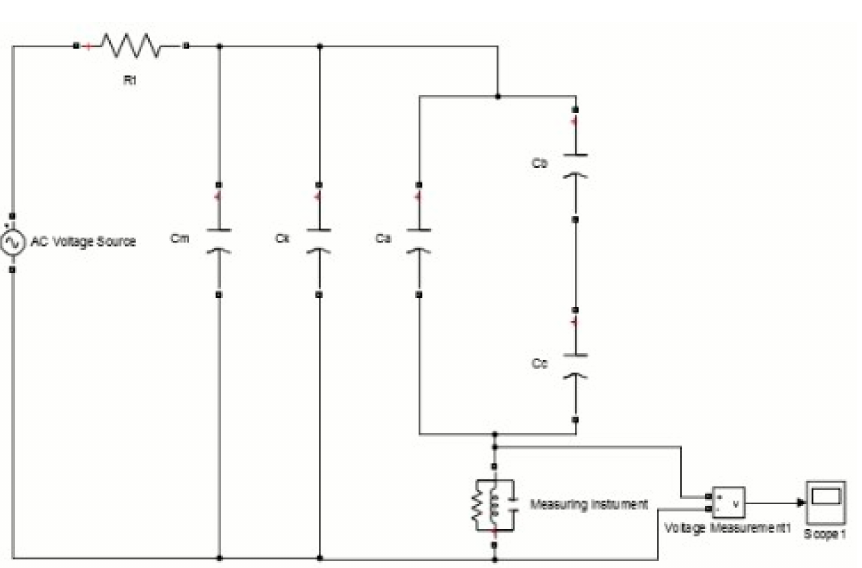
Figure 8. Capacitive PD